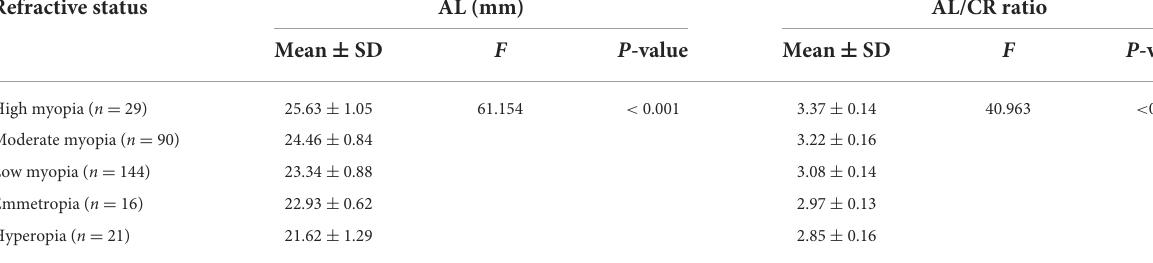
TABLE 3 The AL/CR ratio and AL of participants among different refractive status groups.